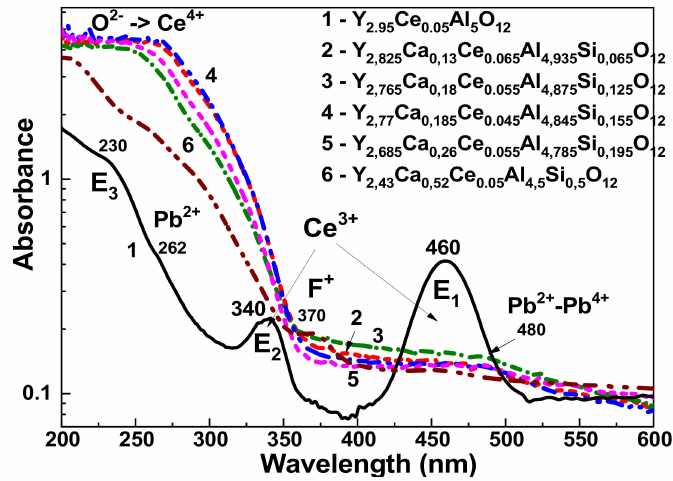
Figure 4. RT absorption spectra of Y 3 − x Ca x Al 5 − y Si y O 12 :Ce SCFs in (log scale) with different Ca and Si content (2–6) in comparison with absorption spectra of YAG:Ce SCF